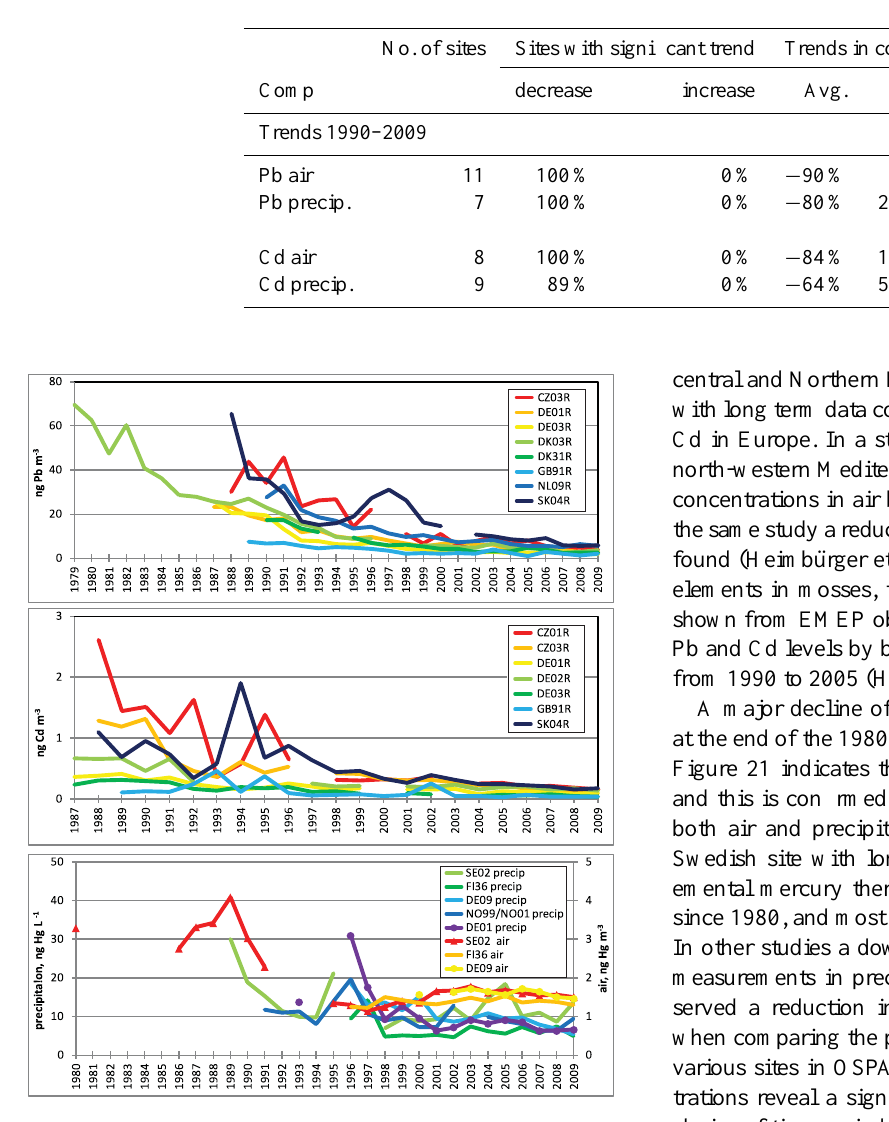
Fig. 21. Change of Pb (top) and Cd (middle) concentration in aerosol and mercury in air and precipitation (bottom) at selected EMEP stations. Note that it is not necessarily the same sites that have time series in both air and